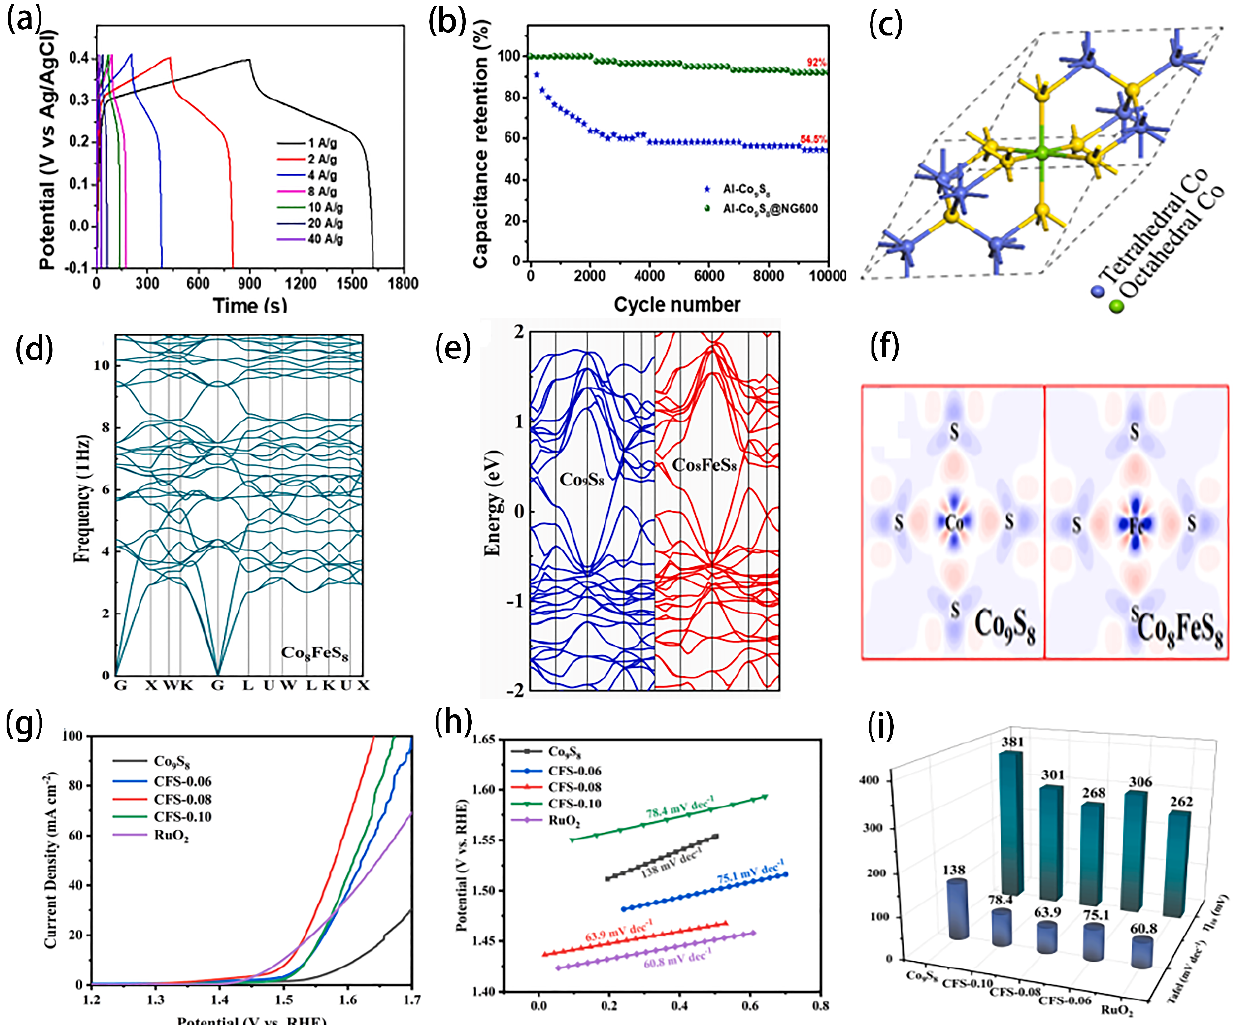
Figure 9. ( a ) GCD patterns performed at various applied current densities from 1 to 40 A/g for core-shell Al-Co 9 S 8 @NG600. ( b ) Cyclic life analysis for Al-Co 9 S 8 , Al- Co 9 S 8 @NG600 electrodes at an applied current density value of 20 A/g. Reprinted with permission from Reference [107]. Copy- right (2022) Elsevier Ltd. All rights reserved. ( c ) The primitive unit cell of Co 9 S 8 , Green is octahedral metal, Blue is tetrahedral metal, and Yellow is sulfurs. ( d ) The phonon dispersions of Co 8 FeS 8 . ( e ) Calculated band structures. ( f ) charge density difference. (For interpretation of the references to colour in this figure legend, the reader is referred to the web version of this article). ( g ) The LSV curves for different catalysts in 1.0 M KOH at 5 mV s − 1 . ( h ) Tafel slopes. ( i ) Corresponding over- potential at 10 mA cm − 2 and Tafel slopes of different catalysts, respectively. Reprinted with per- mission from Reference [108]. Copyright (2022) Elsevier Ltd. All rights reserved.